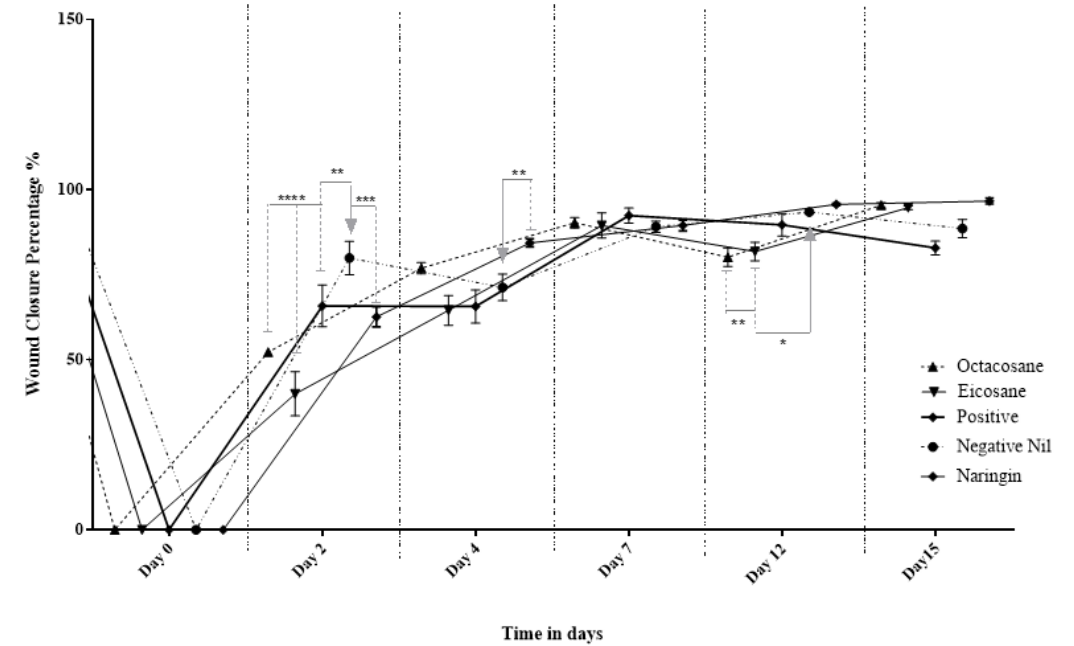
Figure 5. Percentage wound contraction of diabetic wounds from different treatment groups. * p < 0.05, ** p < 0.01, *** p < 0.001, **** p < 0.0001.